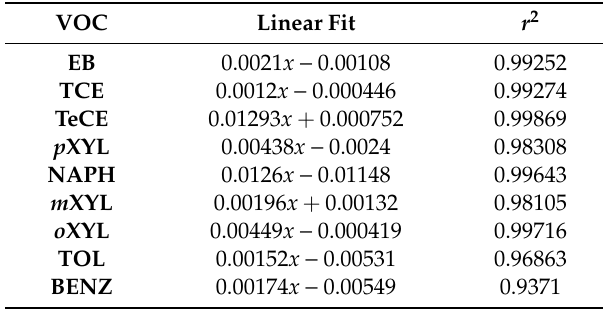
Table 4. Linear fit functions and r 2 -values of the respective VOC. The calibration functions were obtained using the kinetic method, i.e., evaluating the slope of the tangent in the linear range of enrichment curve. The linear concentration was from 1 ppm to 25 ppm for each VOC.